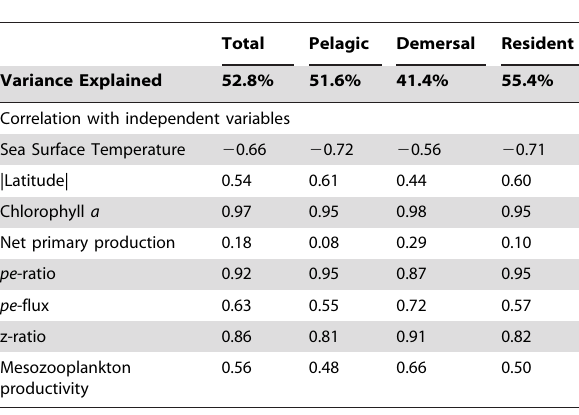
Table 3. Results from the PLSR analysis with percentage of fishery yield explained by the first component and correlations between independent variables and the first component